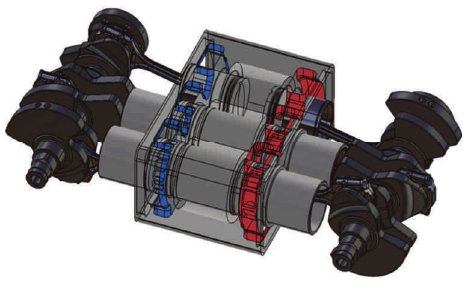
Fig. 1. CAD model of the engine